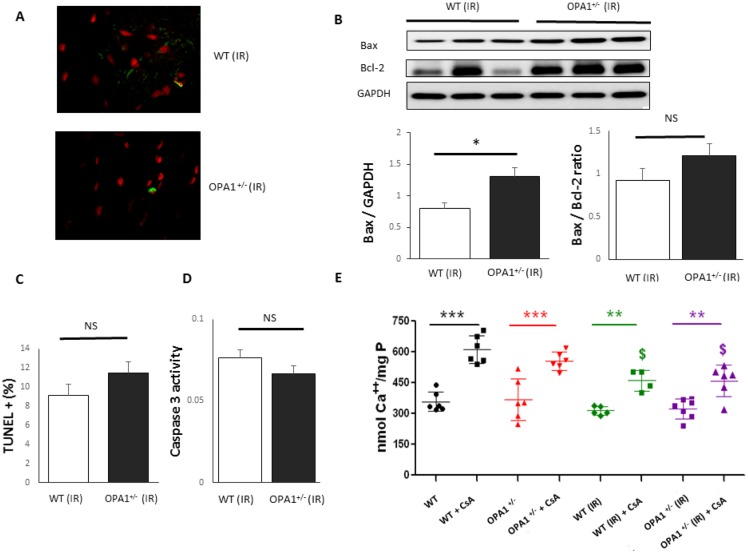
Apoptosis assessment and sensitivity to mPTP.A: Examples of TUNEL images of left-ventricular sections in confocal microscopy (70x magnification) after I/R. Cell nuclei are stained in red (propidium iodide, wavelength = 620 nm). TUNEL-positive nuclei appear in green (fluorescein, wavelength = 460 nm). B: Bax and Bcl-2 protein expressions (n = 4-6/group). C: Percentage of TUNEL-positive nuclei compared to total nuclei (n = 8 in Opa1+/- and 7 in WT). D: Caspase 3 activity amongst Opa1+/- (n = 7) and WT (n = 7) groups. E: mPTP opening sensitivity at baseline and after I/R (n = 6/group). Required calcium overload for mPTP opening in WT and Opa1+/- groups at baseline, after I/R, with or without use of cyclosporine analog (CsA). The I/R protocol included 45 minutes of ischemia and 2 hours of reperfusion. Values are mean ± SEM. *p<0.05, **p<0.01, ***p<0.001. $p< 0.05 compared to the same group at baseline + CsA. Non-parametric Mann-Whitney test (TUNEL and Bax/Bcl2 ratio) and t-test (Bax expression and caspase 3 activity).